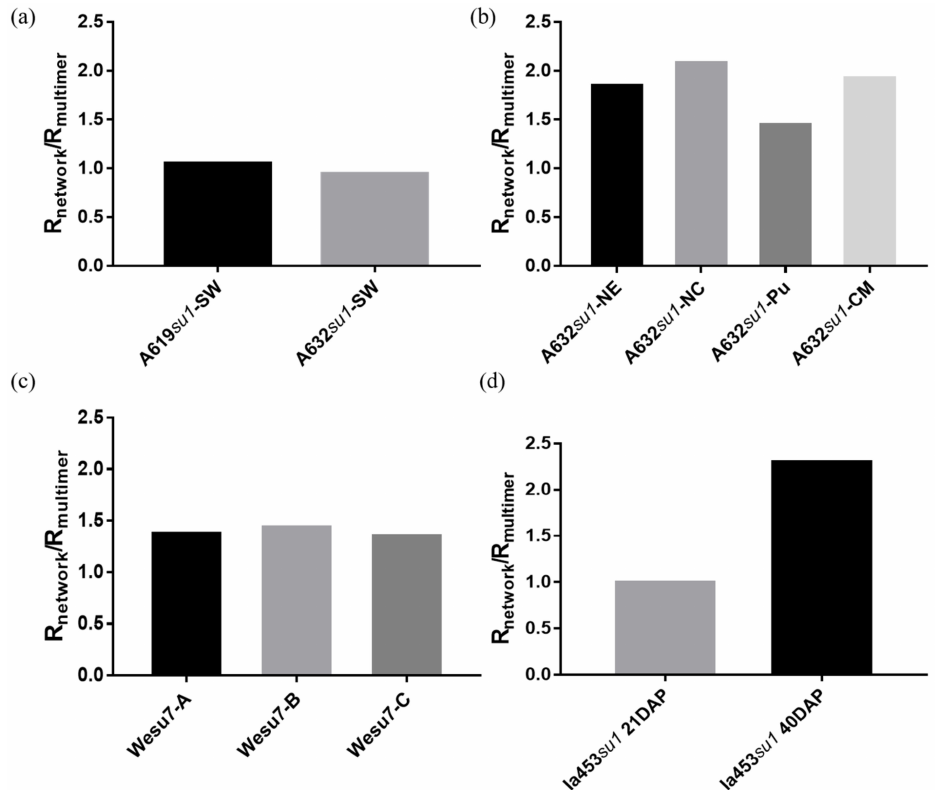
Figure 8. R network / R multimer for ( a ) A619 su1 -SW and A632 su1 -SW, ( b ) A632 with di ff erent su1 mutants, ( c ) Wesu7-A, Wesu7-B, and Wesu7-C, and ( d ) Ia453 su1 harvested 21 days after pollination (“Ia435